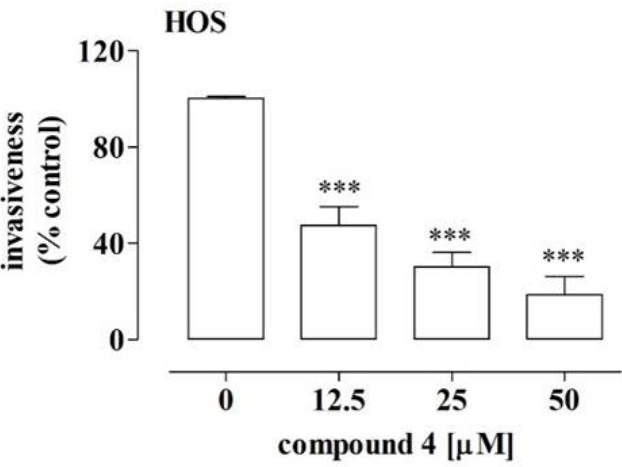
Figure 6. Effect of compound 4 on the invasiveness of the HOS cells. The cells were treated with the compound at the indicated concentrations for 24 h. The cell invasiveness was determined by means of the BME-coated transwell assay. The results are mean values ± SD of at least three independent experiments. Statistically significant differences: ***—at p < 0.001 in comparison with the untreated cells (one-way ANOVA followed by Dunnett’s post-hoc test).